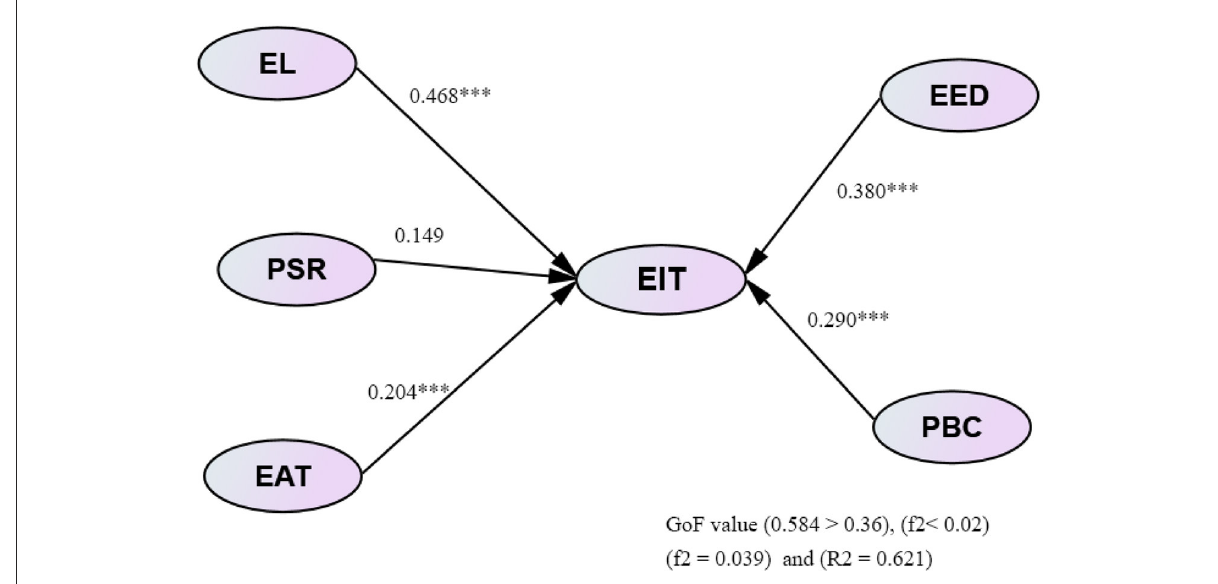
FIGURE2 Structural model analysis results. *** significance at